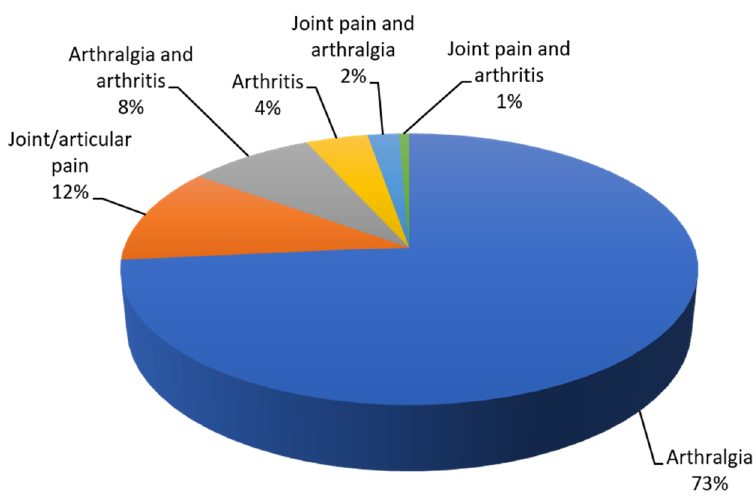
Figure 3. Terminologies used in case studies to describe joint signs / symptoms (% of total